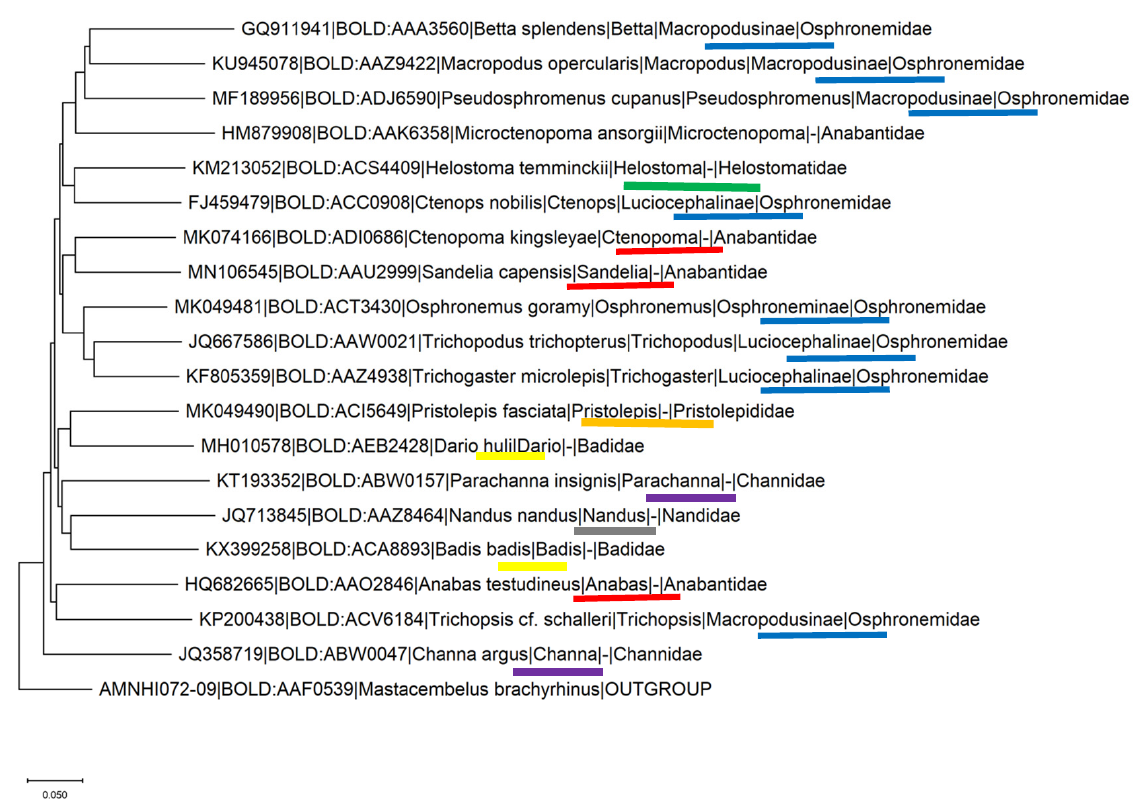
Figure 25. Phylogenetic tree of the COI-5p gene records of the order Anabantiformes. Nineteen nucleotide sequences from different species were retrieved from BoldSystem [46], such that every genus is represented by one sequence. Tree was constructed using Neighbor-joining method using Kimura 2 Distance Model, with pairwise deletion and MUSCLE alignment in the MEGA-X software [47]. A sequence from the species Mastacembelus brachyrhinus that belongs to the order Synbranchi- formes was used as an outgroup. Leaves are marked with genbank_accession |Bold_bin_id|species|genus|subfamily|family. Sequences that belong to the same taxonomic family are marked with the same